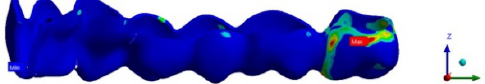
Figure 5. NO ATT contact pressure.